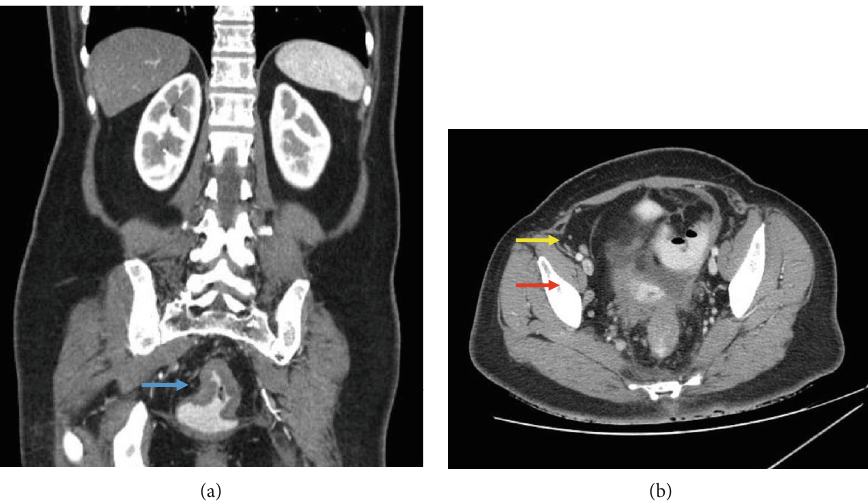
Figure 3: CT of the abdomen and pelvis in coronal view (a) showing a rectal mass and in axial view (b) showing small noncalci fi c right internal (red arrow) and right external (yellow arrow) iliac lymph nodes.